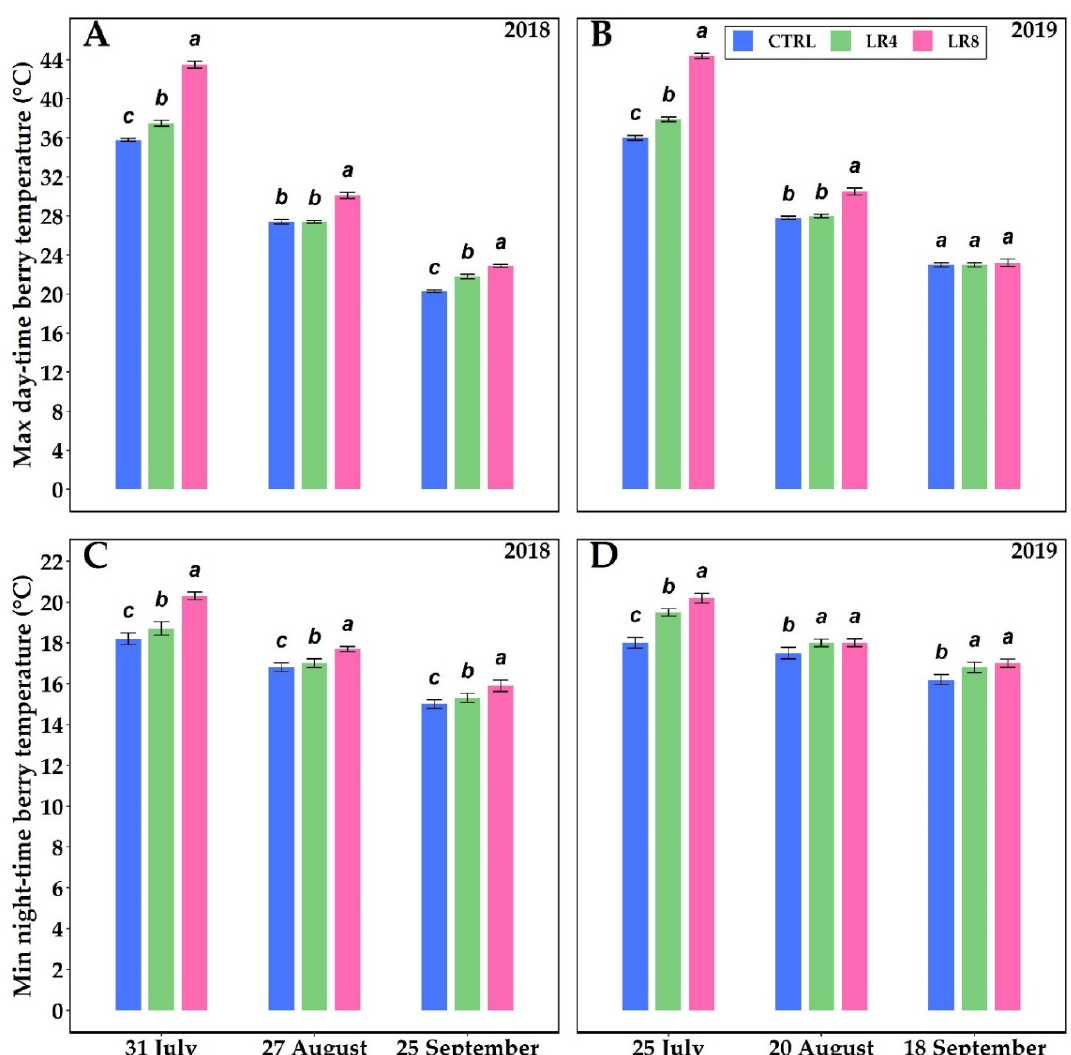
Figure 3. Maximum daytime temperature ( ◦ C) (( A ), 2018; ( B ), 2019) and minimum night-time temperature ( ◦ C) (( C ), 2018; ( D ), 2019) of V. vinifera berries with three different defoliation managements: four leaf removal (LR4, green column), eight leaf removal (LR8, pink column), and no defoliation (CTRL, blue column). Measurements were conducted at full veraison (31 July 2018 and 25 July 2019), mid-maturation (27 August 2018 and 20 August 2019) and full maturation (25 September 2018 and 18 September 2019). Different letters within the same parameter indicate significant differences. Data (mean ± SE, n = 10) were subjected to one-way ANOVA (LSD test, p ≤ 0.05).